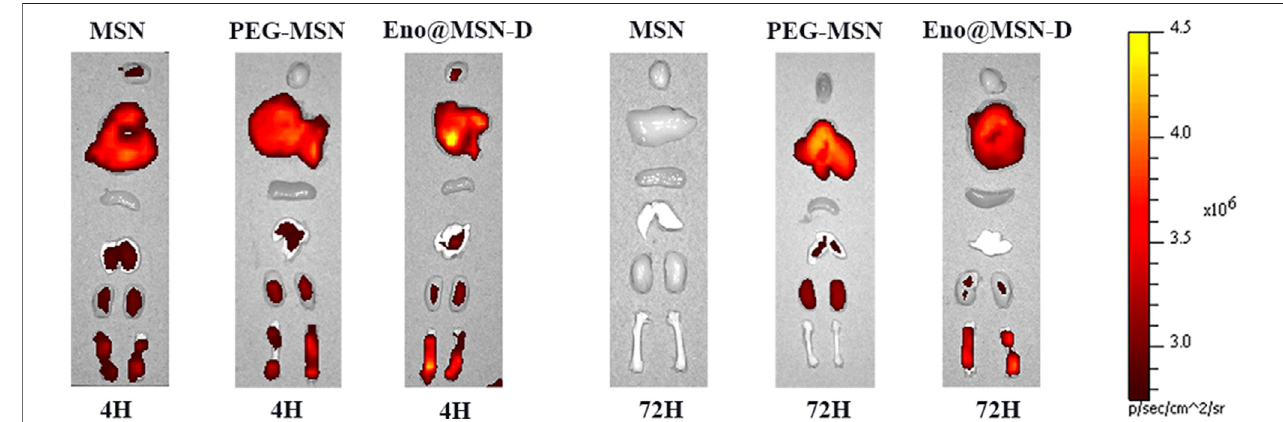
FIGURE6| Invivo targeted fl uorescenceexperiment: fl uorescencediagramsofvariousorgans4and72 haftertheinjectionofMSN,PEG-MSN,andEno@MSN-D nanoparticles.